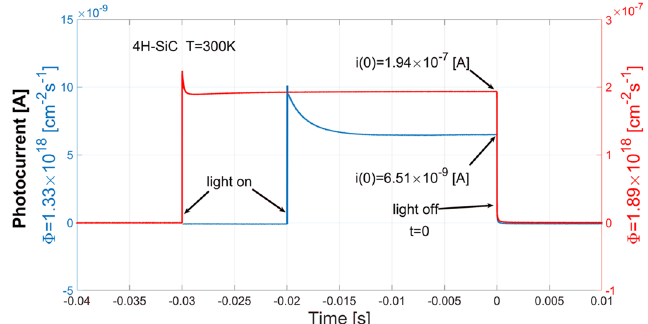
Figure 14. Photocurrent pulse waveforms induced by an incident light with a wavelength of 375 nm for two different values of photon flux: Φ = 1.33 × 10 18 cm −2 s −1 (blue), and Φ = 1.89 × 10 18 cm −2 s −1 (red).